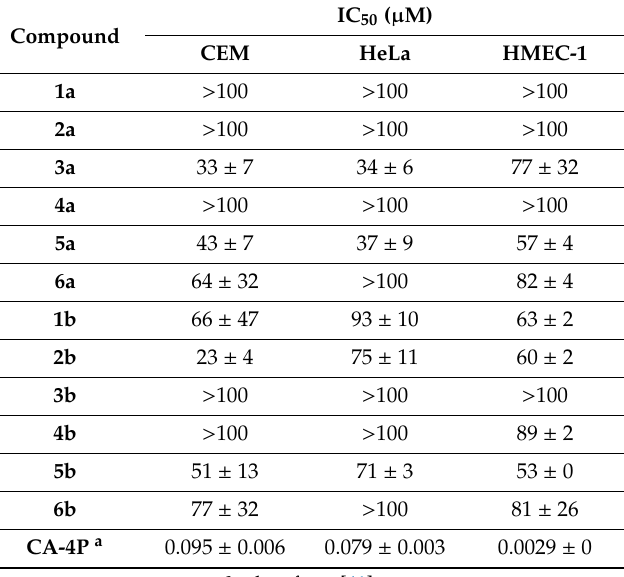
Table 1. Antiproliferative activity of compounds 1a – 6a and 1b – 6b in comparison with combretastatin A4P (CA-4P) .